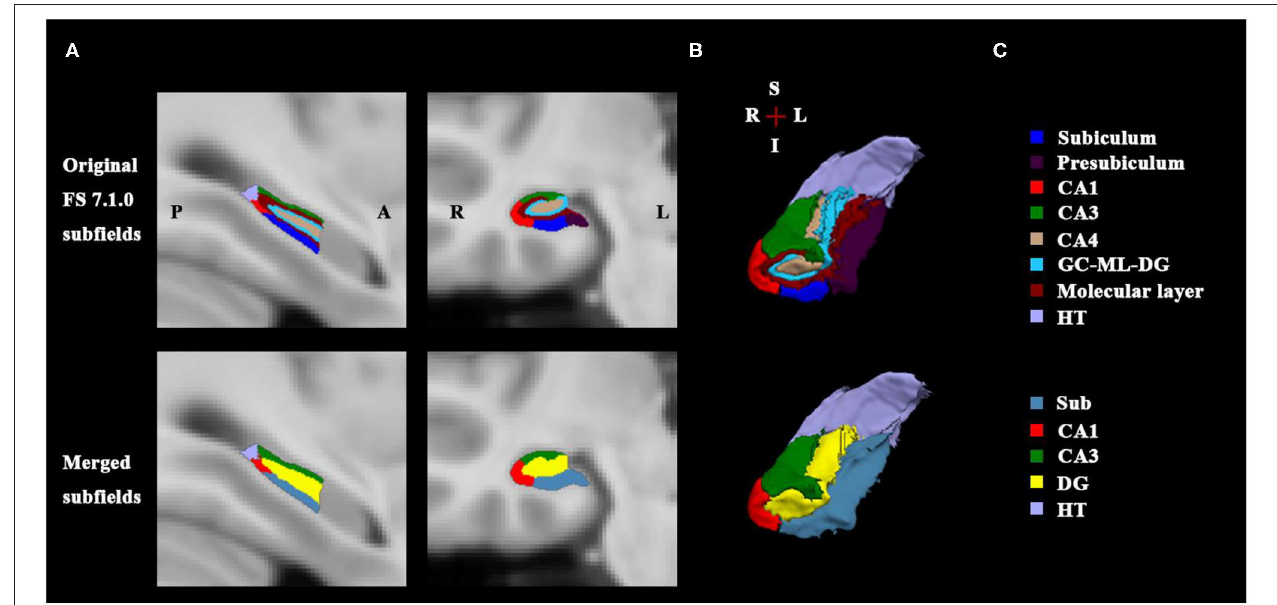
FIGURE 1 | Right posterior hippocampal subfields of sectional view and 3D view. (A) Shows the sagittal and coronal slices of original FS 7.1.0 subfields (up) and the merged subfields (down). (B) Illustrates the 3D rendering of the hippocampal subfields generated from FS 7.1.0 segmentation (up) and from the merged method (down); The merged subfields are defined as the seed masks for the SBFC calculation. (C) Lists the corresponding subfield labels with specific color bar; the Sub includes FS labels subiculum and presubiculum; the DG comprises of FS labels CA4, GC-DG-ML, and molecular layer. FS, FreeSurfer; A, anterior; P, posterior; L, left; R, right; S, superior; I, inferior; HT, hippocampal tail; DG, dentate gyrus; CA, cornu ammonis; GC-ML-DG, granule cell layer and molecular layer of the dentate